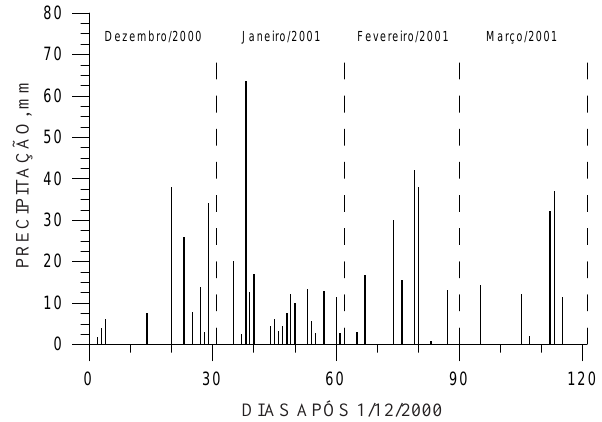
Figura 1. Precipitações pluviais ocorridas no local do experimento, nos meses de dezembro de 2000 e de janeiro a março de